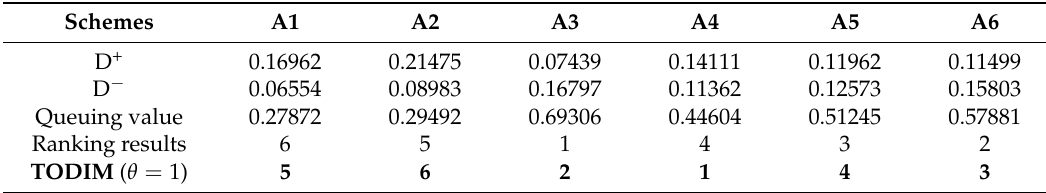
Table 13. Schemes in TOPSIS method Ranking